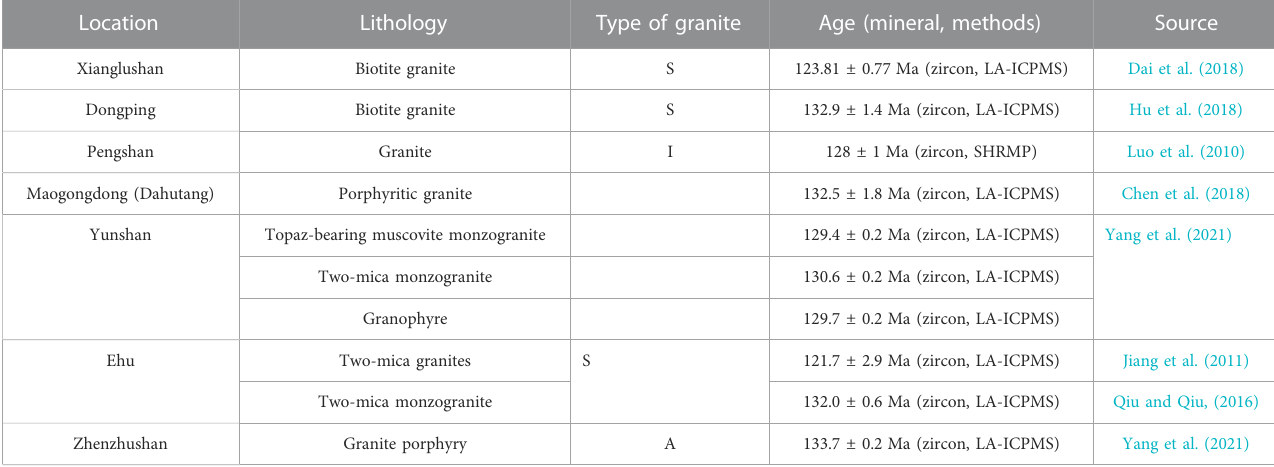
TABLE 1 Early Cretaceous granitoids related to lithospheric extension in the EJM.